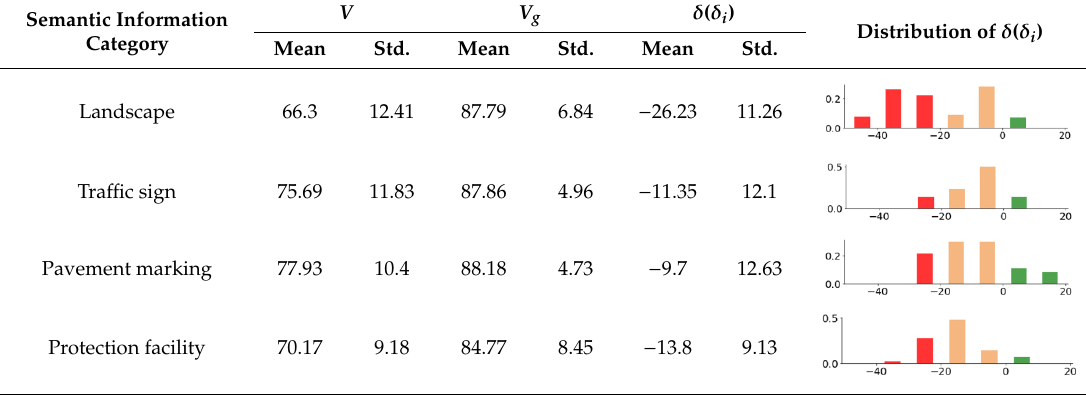
Table 4. The statistical descriptions of actual speed, geometry-determined speed and environment- modified speed.